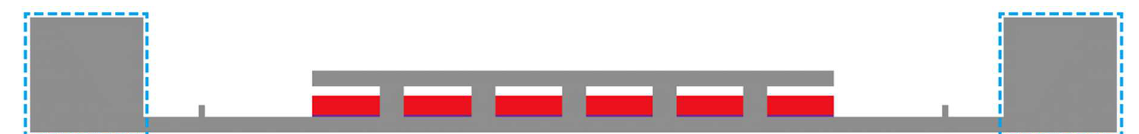
Figure 4. Schematic of the fluid domain used in CFD analyses.